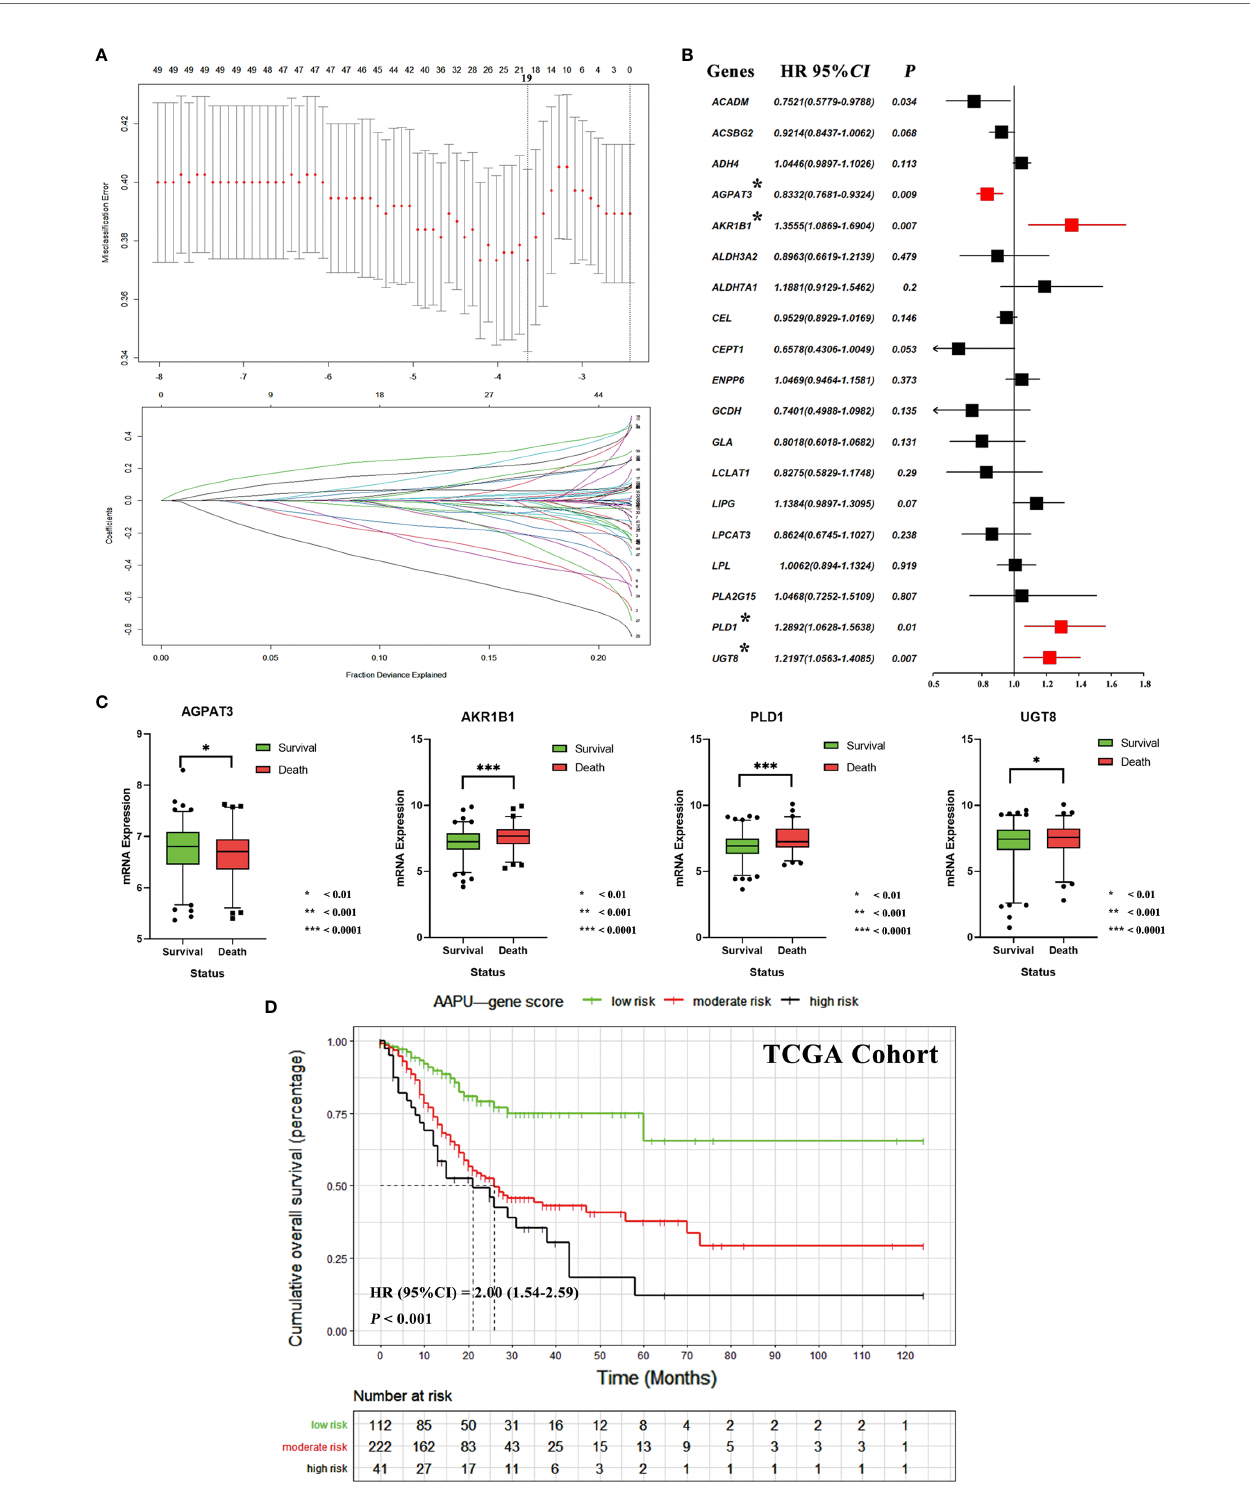
FIGURE 3 | (A) Tuning parameter ( l ) selection in the LASSO algorithm performed using 1,000-fold cross-validation via the minimum criteria. The LASSO coef fi cient pro fi les of the 19 genes. A coef fi cient pro fi le plot is produced versus the log ( l ). The binomial deviance is plotted versus log ( l ) and the black vertical lines are plotted at the optimal l based on the minimum criteria. (B) The forest plots of multivariate Cox analysis results of 19 genes selected by LASSO algorithm. (C) The mRNA expression difference of AGPAT3, AKR1B1, PLD1, and UGT8 between alive and dead GC patients. (D) The KM survival curves of low-, moderate- and high-risk “ AAPU ” genes pro fi le in TCGA